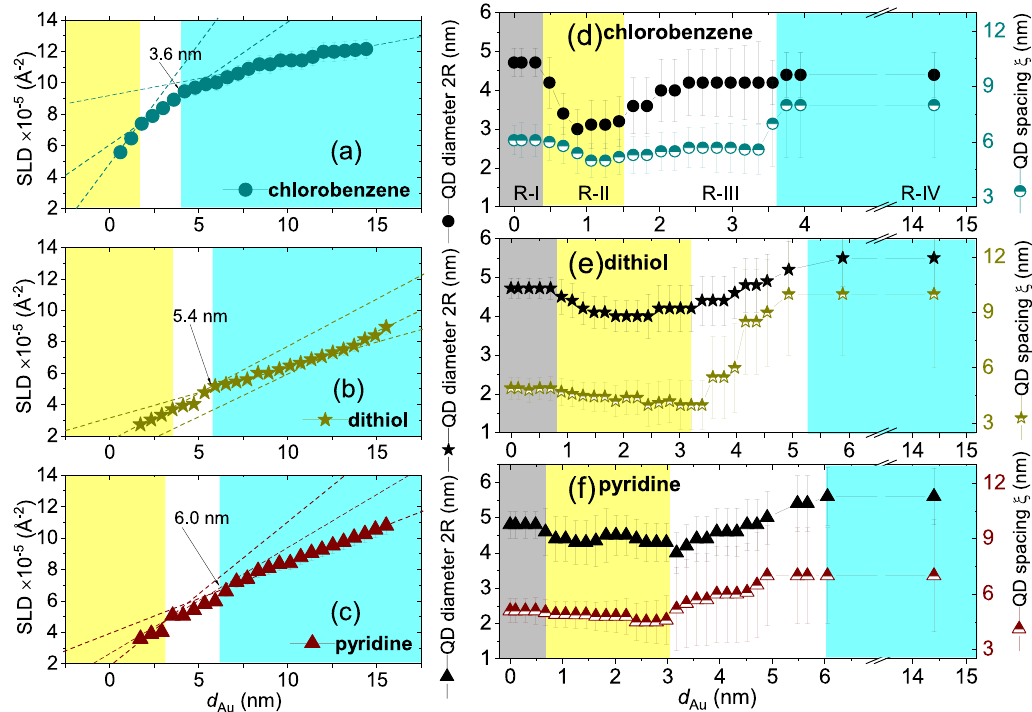
Figure 7. ( a – c ) Thickness dependence of SLD versus d Au for the three solvents ( a ) chlorobenzene , ( b ) dithiol and ( c ) pyridine estimated from the one-dimensional vertical line cuts along Q z at Q y = 0 nm − 1 . Out of total number of frames ( ≈ 6000) collected within 600 s, the data for the plots above were extracted for every 250th frame, which correspond to an interval of 25 s and a thickness of around 0.6 nm. The three different slopes corresponding to different stages of real-time growth evolution of the species have been indicated. ( d – f ) Thickness dependence of the QD diameter (2 R ) and the corresponding inter-QD spacing ( ξ ) for the